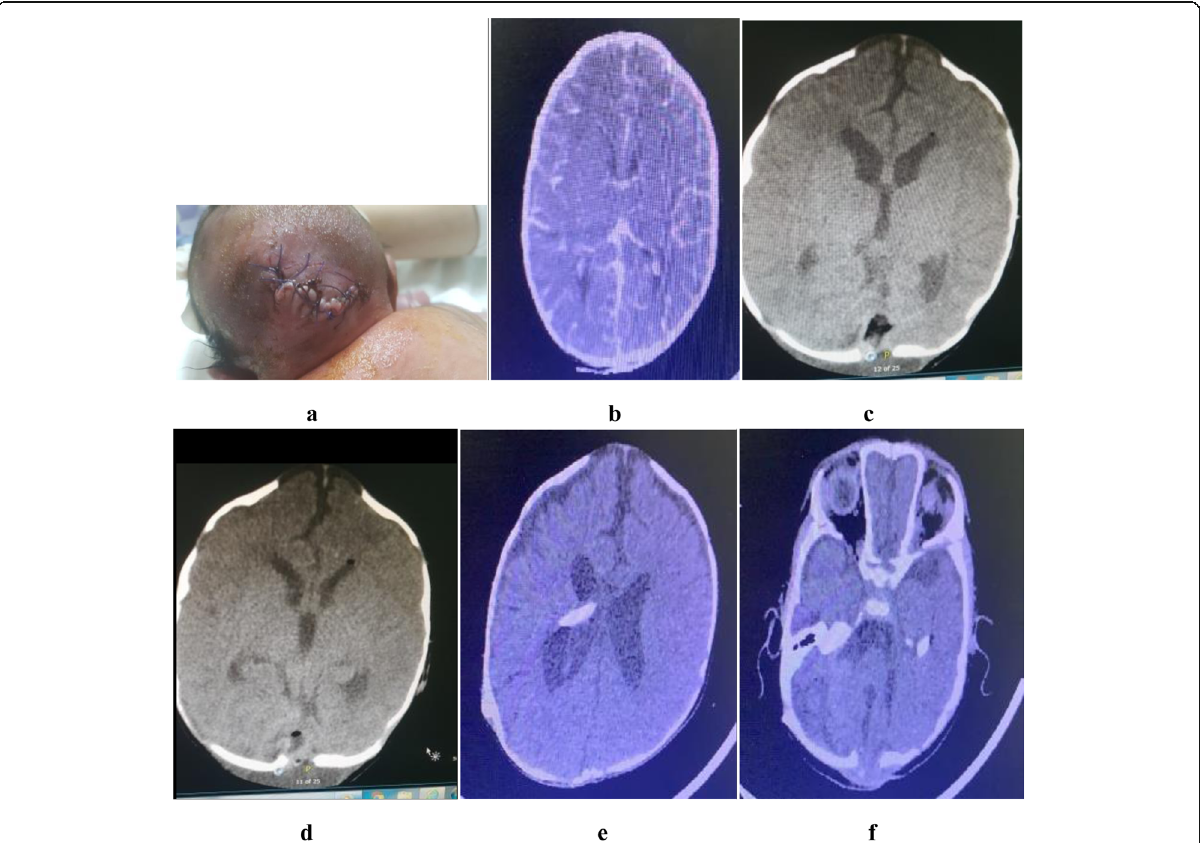
Fig. 2 A boy who was operated for occipital encephalocele when he was 7 days old. a He developed a CSF collection at the surgical site 1 week following the surgery. b Preoperative axial CT brain. c , d Postoperative axial CT brain showing that he developed dilation of the supratentorial ventricles and CSF collection at the surgical site. e , f Axial CT brain after VP shunt insertion showing reduction of the CSF collection size. The